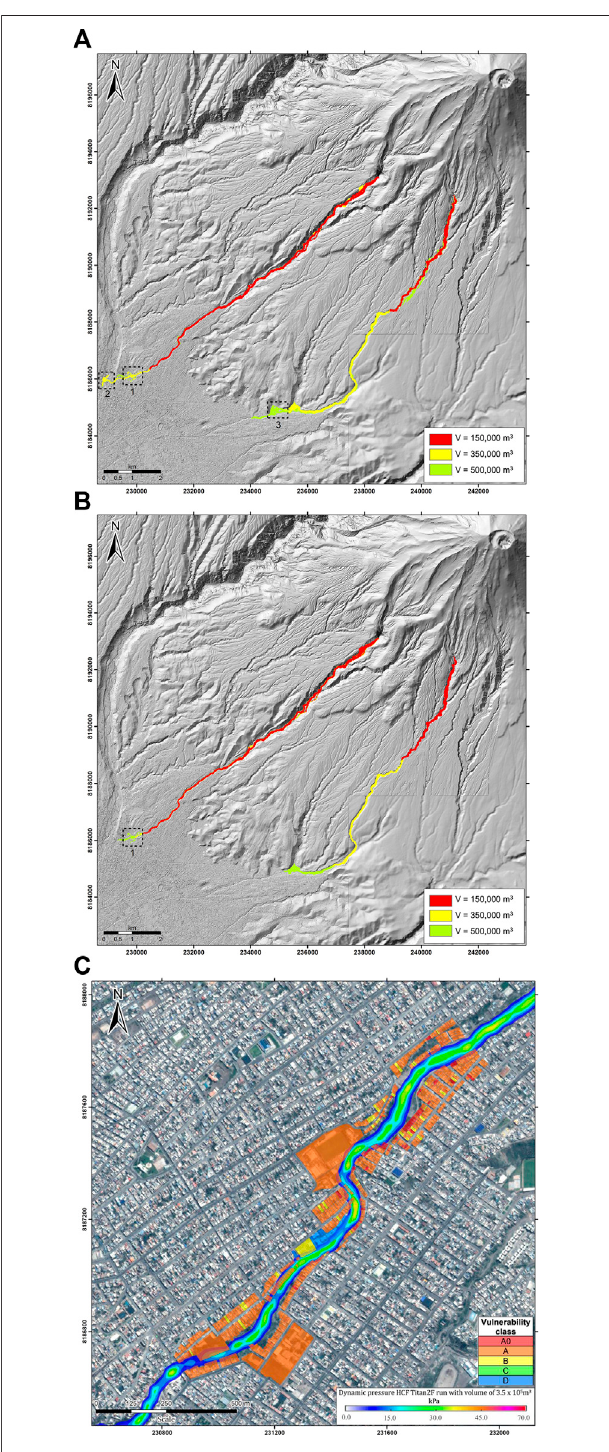
FIGURE 4 | (A) Titan2F-simulated HCFs with a range of three volumes (1.5, 3.5, and 5 × 10 5 m 3 ) in Qda. San Lazaro and Qda. Huarangal-MM. Rectangle #1 shows the overbank near the Progreso bridge down valley San Lazaro. Rectangle #2 shows damming by a moderate volume DF and subsequent runup at the con fl uence of Río Chili. Rectangle #3 indicates the overbank area in the Geronimo – Paucarpata suburb in Huarangal-MM, similar